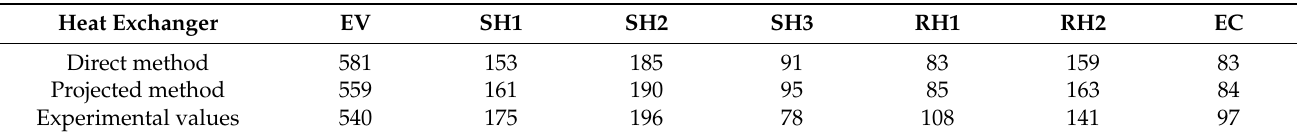
Table 5. Direct method and projected method heat transfer rate results for 100% MCR coal-fired boiler case study.